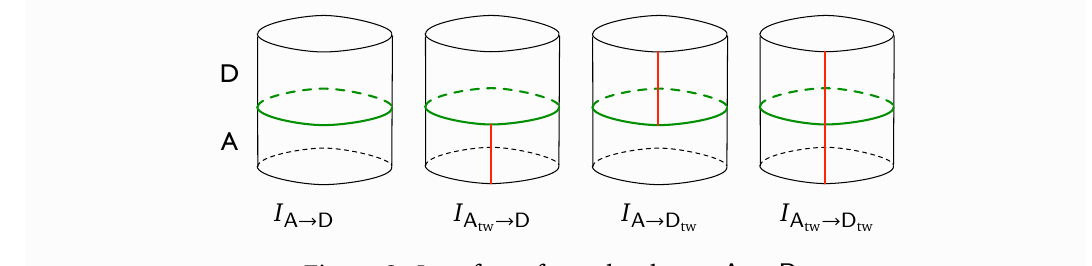
Figure 2: Interfaces from the theory A to D